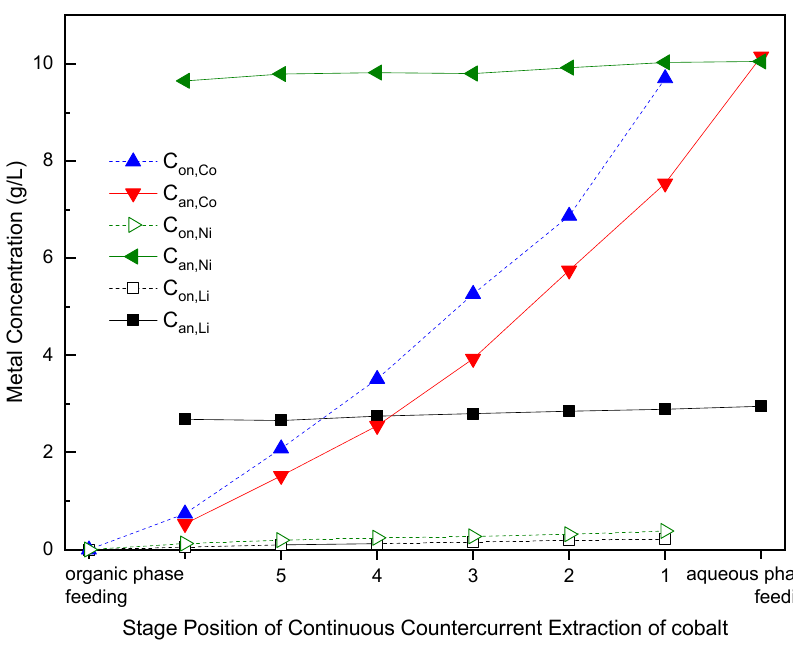
Figure 8. Metals concentrations in conventional continuous-countercurrent-extraction of cobalt. P-507/kerosene: 1:4 v/v ; saponification: 60%; O/A: 1:1; retention times in each tank: 5 min).